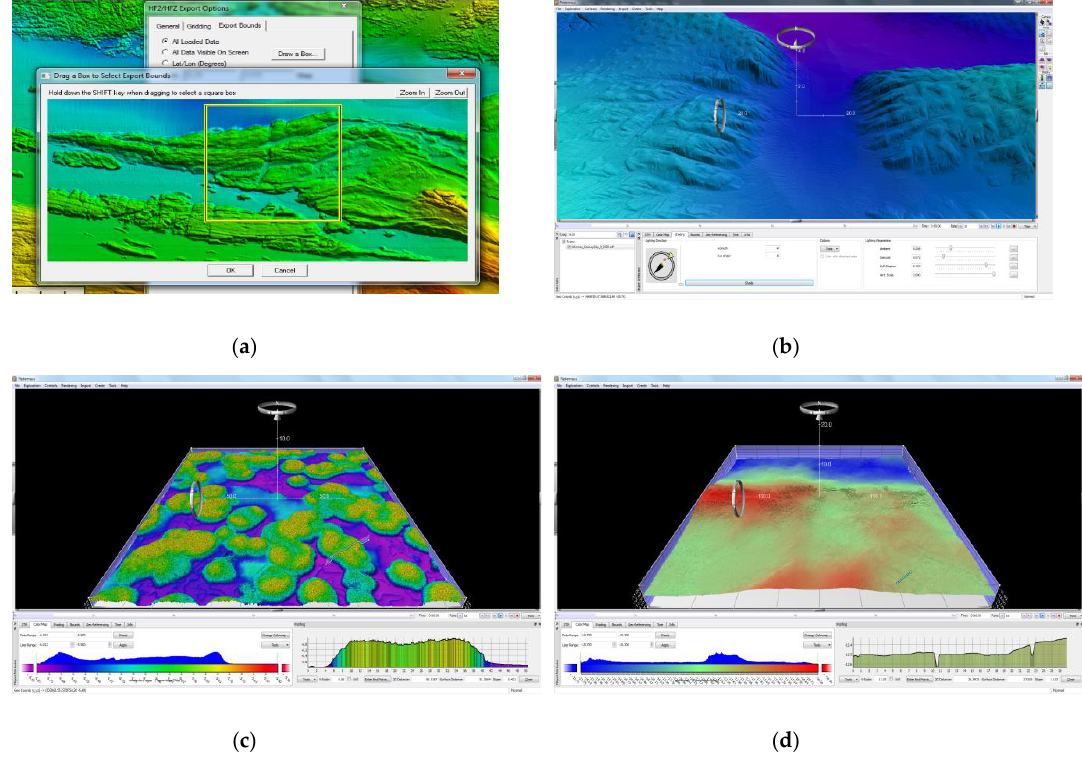
Figure 2. Sample scenarios generated from real data ( a,b ) and purely synthetic creations ( c,d ). The top row illustrates the selection of a shape guide from a site in a priori bathymetry (Galway Bay, Ireland) using GlobalMapper ( a ). The resulting multi-fractal interpolated seabed model is presented in Fledermaus. The bottom row scenarios emulate the features of a shallow water coral bank ( c ) and evidence of trawl scarring ( d ) and are completely synthetic.